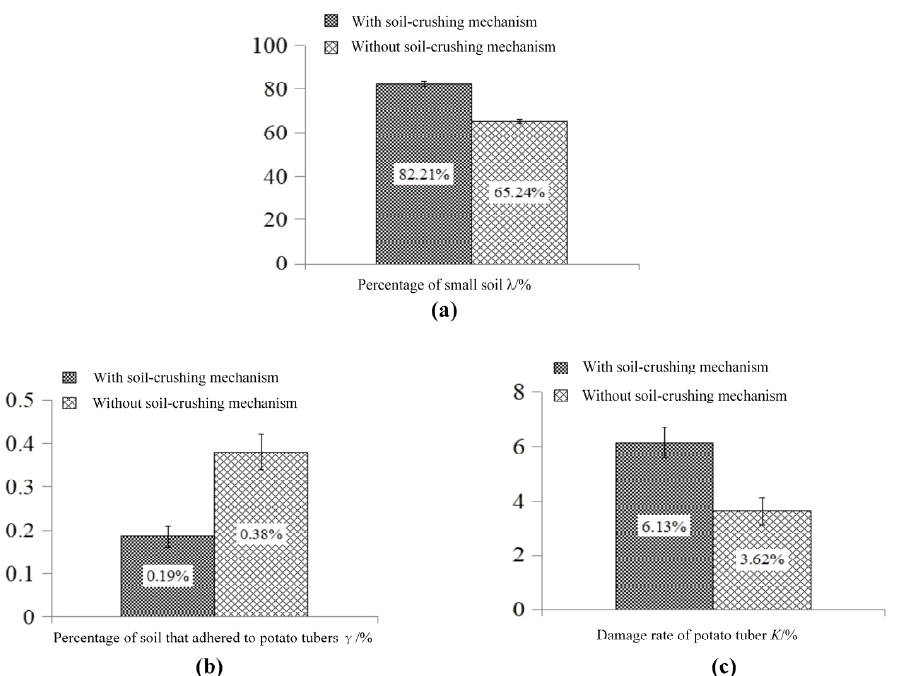
Figure 11. The statistical comparison of the respective assessment index in different scenarios. ( a ) Percentage of small soil; ( b ) percentage of soil that adhered to potato tubers; ( c ) damage rate of potato tuber.